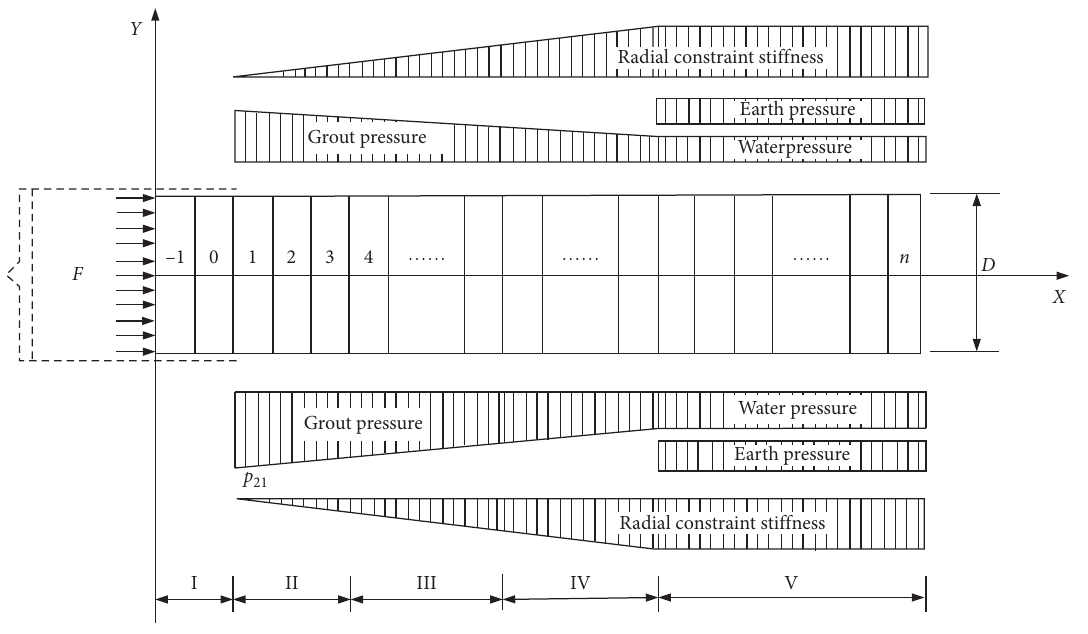
Figure 4: Mechanical model for segment uplift analysis during shield